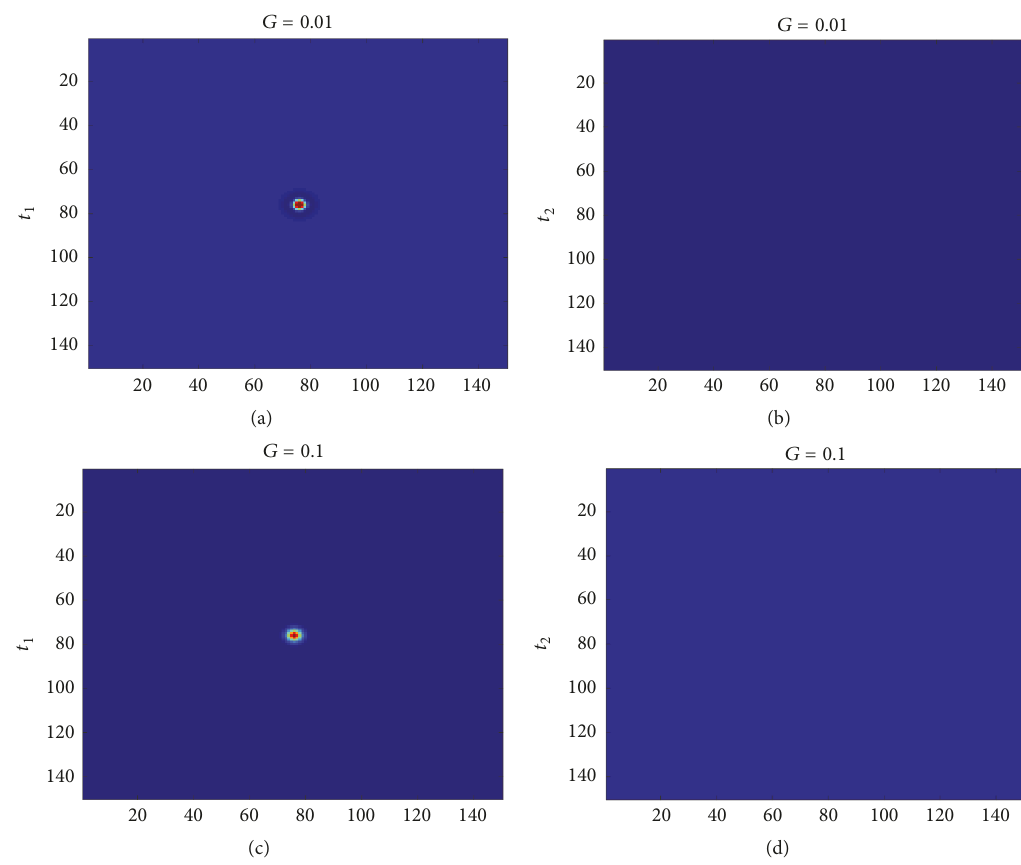
Figure 15: The snapshots of spatial distribution of membrane potential with color scale for neurons in the square array network for 𝑘 = 0 and 𝐷 = 1 at 𝑡 1 = 2 time units and 𝑡 2 = 6 time units. ((a), (b)) 𝐺 = 0.01 and ((c), (d)) 𝐺 = 0.1 .